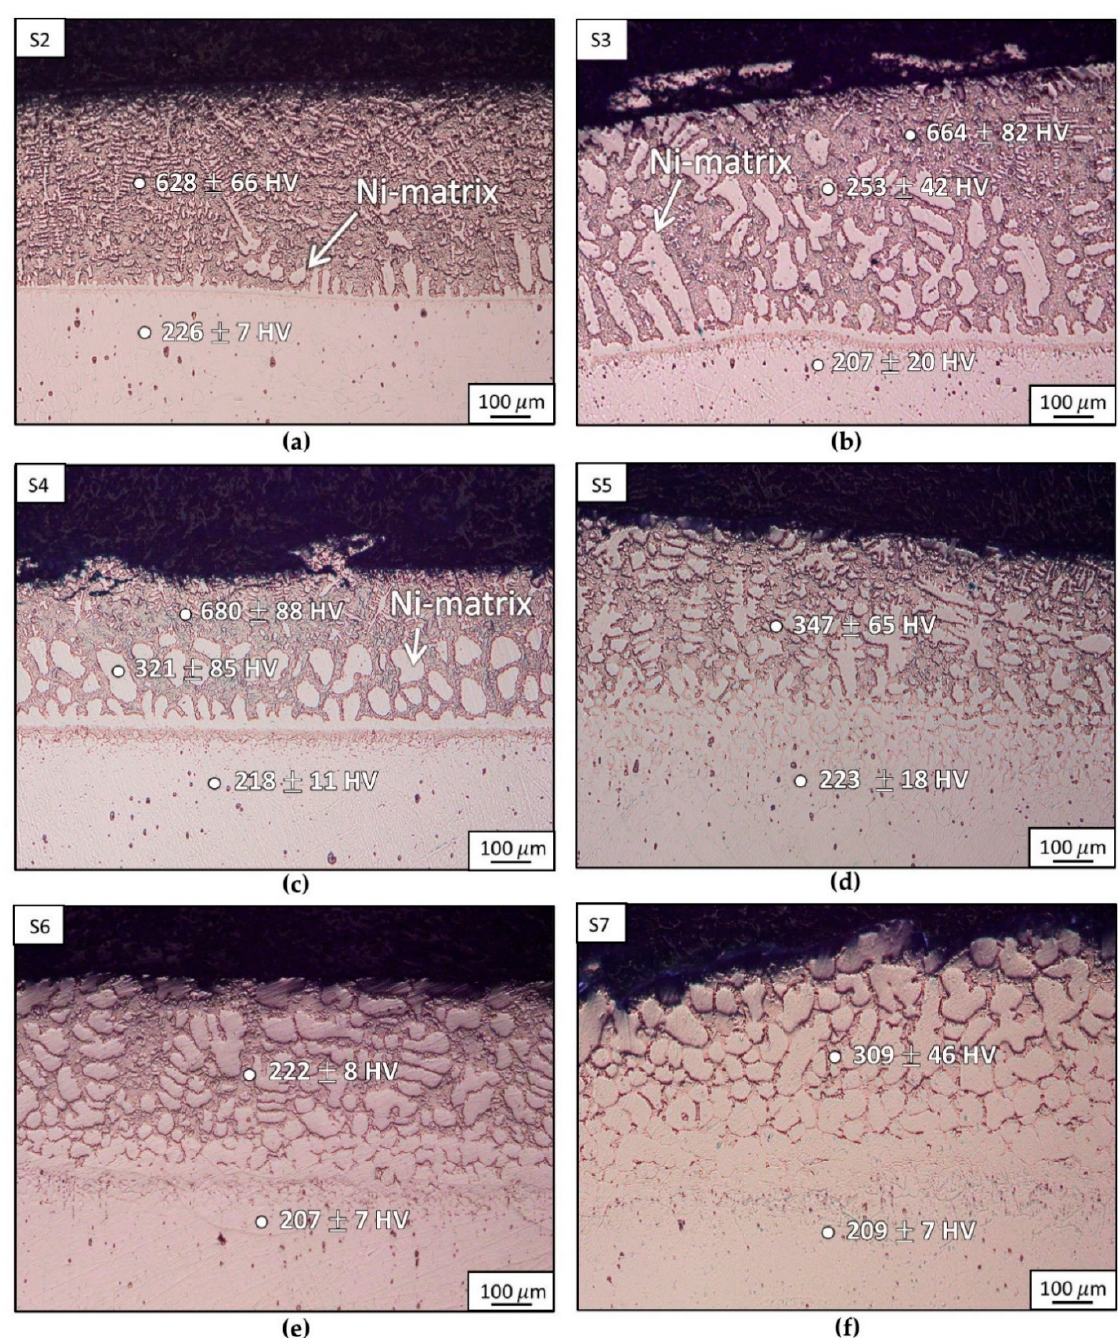
Figure 3. Microstructure and microhardness analysis of induction brazing results of different process parameters: ( a ) 1050 ◦ C for 2 min; ( b ) 1050 ◦ C for 10 min; ( c ) 1050 ◦ C for 20 min; ( d ) 1150 ◦ C for 2 min; ( e ) 1150 ◦ C for 10 min; ( f ) 1150 ◦ C for 20 min.